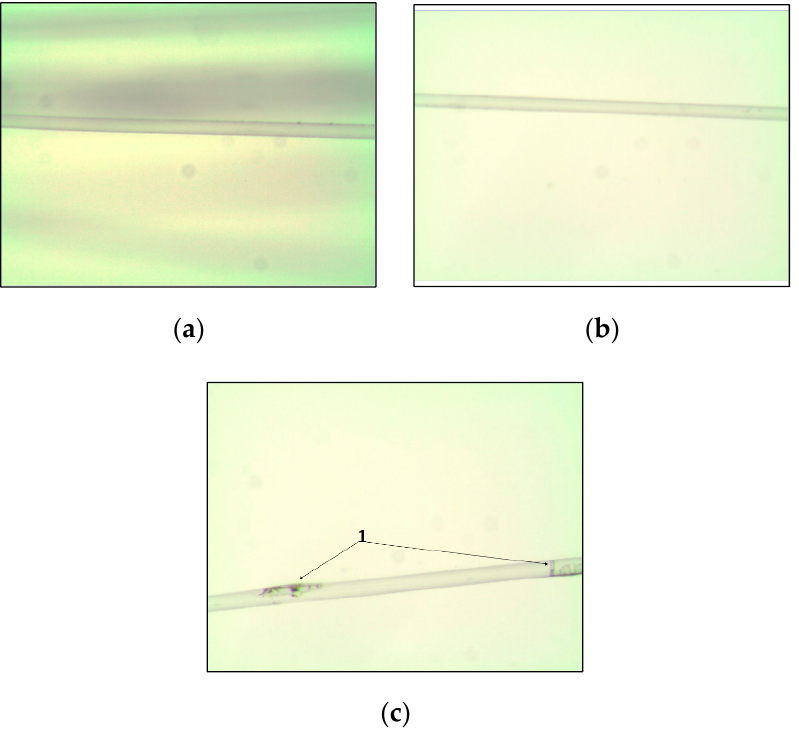
Figure 3. Images of one filament from melt-spun PLA multifilament yarns formed from ( a ) pure PLA polymer (A yarns), ( b ) PLA polymer modified with myrrh ethanolic extract (B yarns), ( c ) PLA polymer modified with myrrh aqueous extract (C yarn). Number 1 indicates unmelted myrrh aqueous extract derivative.